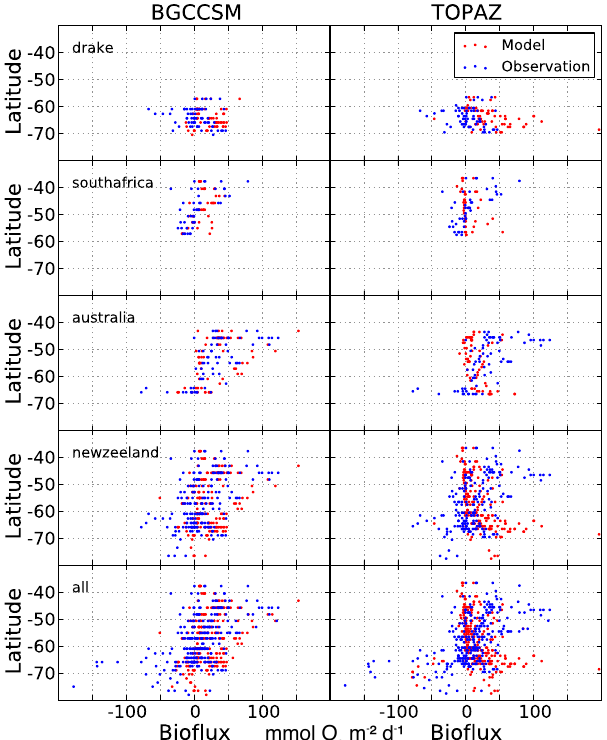
Figure 11. Scatterplots of observed (blue) and model (red) O 2 bioflux (mmolm − 2 d − 1 ) versus latitude in four regions of the Southern Ocean. All observations that fall on a specific grid cell at a specific year day are averaged to one value. Models are subsampled at the location and year day of the observations.